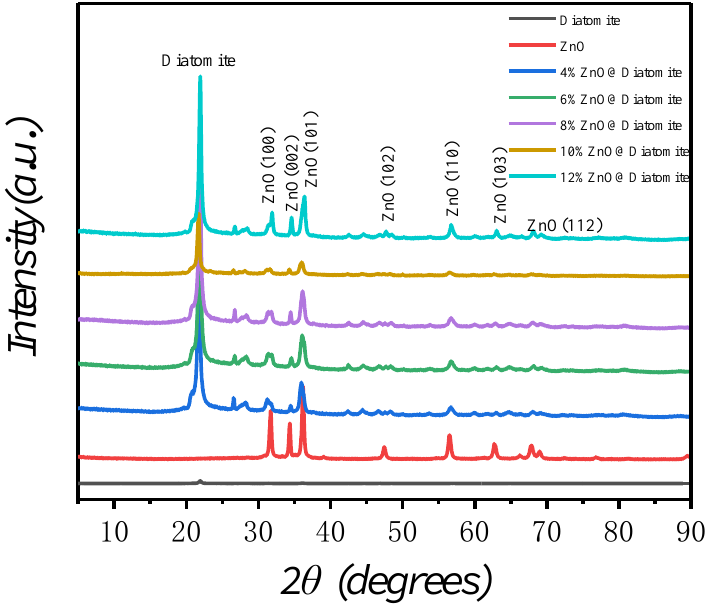
Figure 1. XRD patterns of pure diatomite, pure ZnO, and X% ZnO@diatomite.